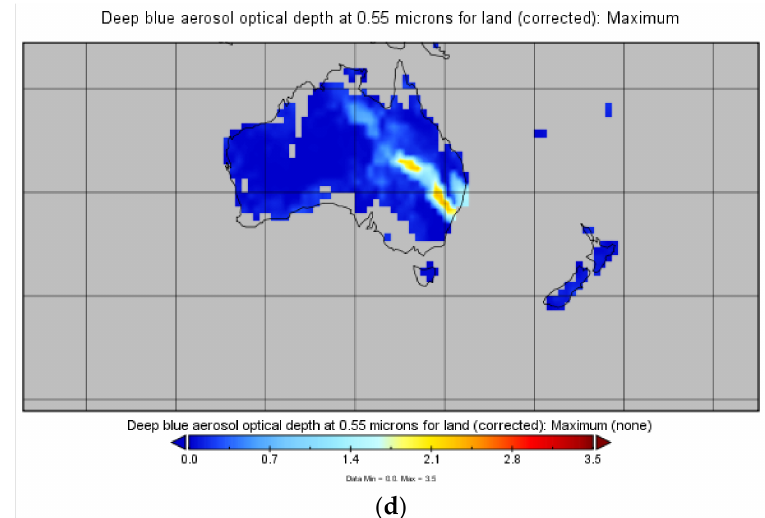
Figure 1. Extent of dust cloud as detected by satellites: ( a ) aerosol subtype vertical profile as derived from CALIOP measurements on 11 February 2019 from 4:27 to 4:40 UTC with CALIPSO satellite path above central Australia ( b ) Extent of dust cloud (red line) as measured by CALIPSO satellite on 11 February 2019 4:27 to 4:40 UTC. ( c ) MODIS Terra satellite image on 13 February 2019 of the dust cloud and hot spots (red) of wildfires in the northern New South Wales (NSW) area and the locations of the main towns and cities (yellow dots) ( d ) Maximum AOD Deep Blue Terra MOD08-D3 for the 13 February 2019 (source: Figure 6 in Nguyen et al., 2019)